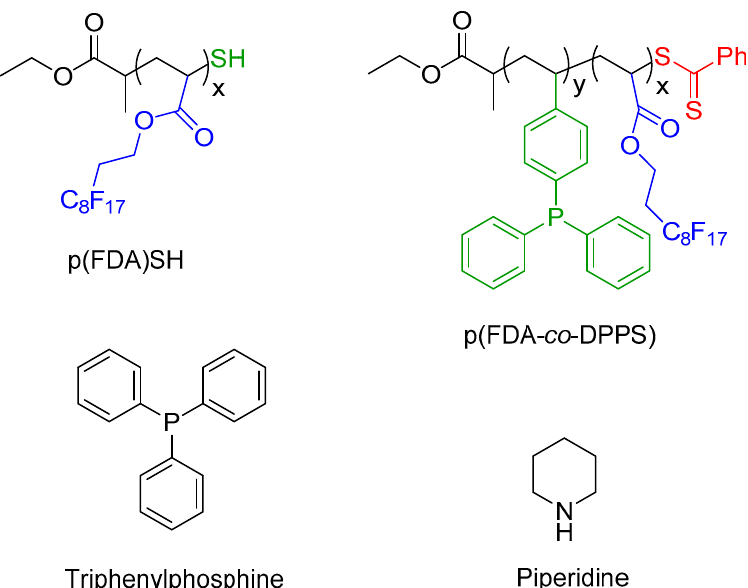
Figure 2. Structures of the complexing polymers and additives used in this study: p(FDA)SH (top left), p(FDA- co -DPPS) (top right), triphenylphosphine (bottom left), piperidine (bottom right) (scCO 2 -soluble groups are highlighted in blue, complexing groups in green, and the protected thiol group in red).